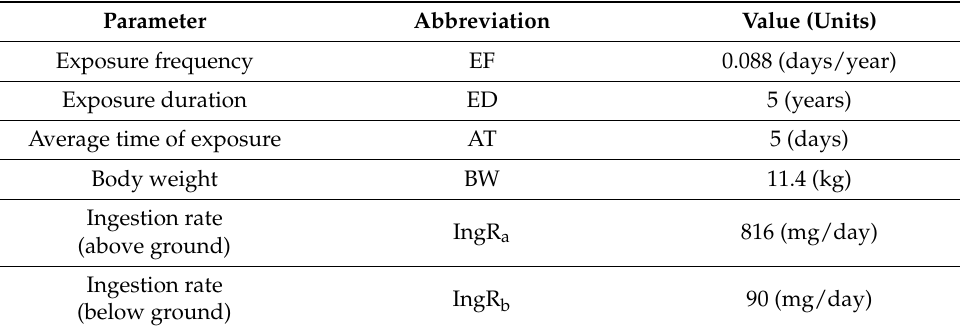
Table 6. Values used in risk factor calculations for a child (1–<2 years